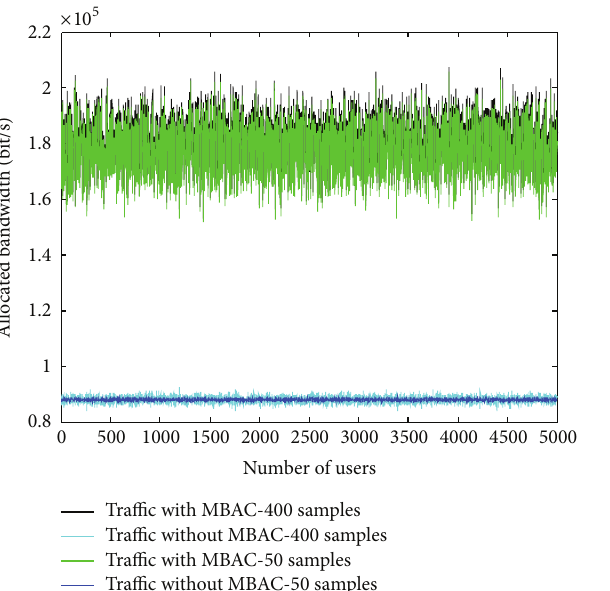
Figure 8: Allocating of bandwidth for the growing number of